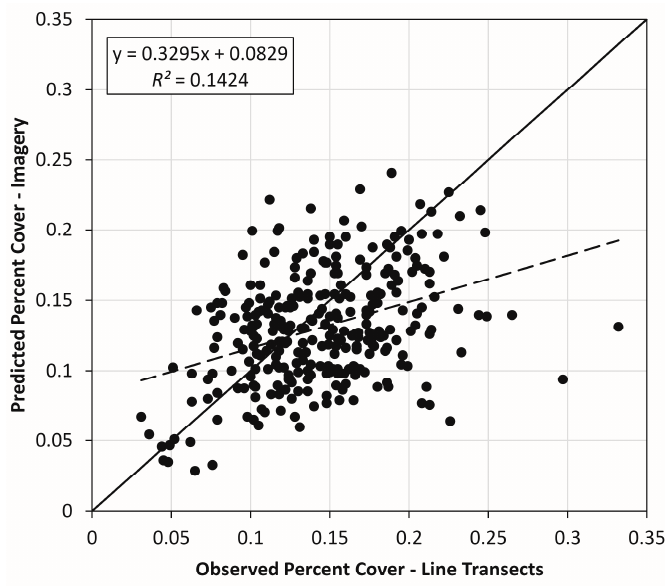
Figure 5. Scatterplot of observed versus predicted percent vegetation cover. Observed percent vegetation area is an average of measurements taken at four line transects in each subarea. Predicted canopy area is estimated from the imagery at NDVI ≥ 0.12 and AVGr ≤ 111. Solid line is 1:1 line; dashed line is regression line (significant at p <